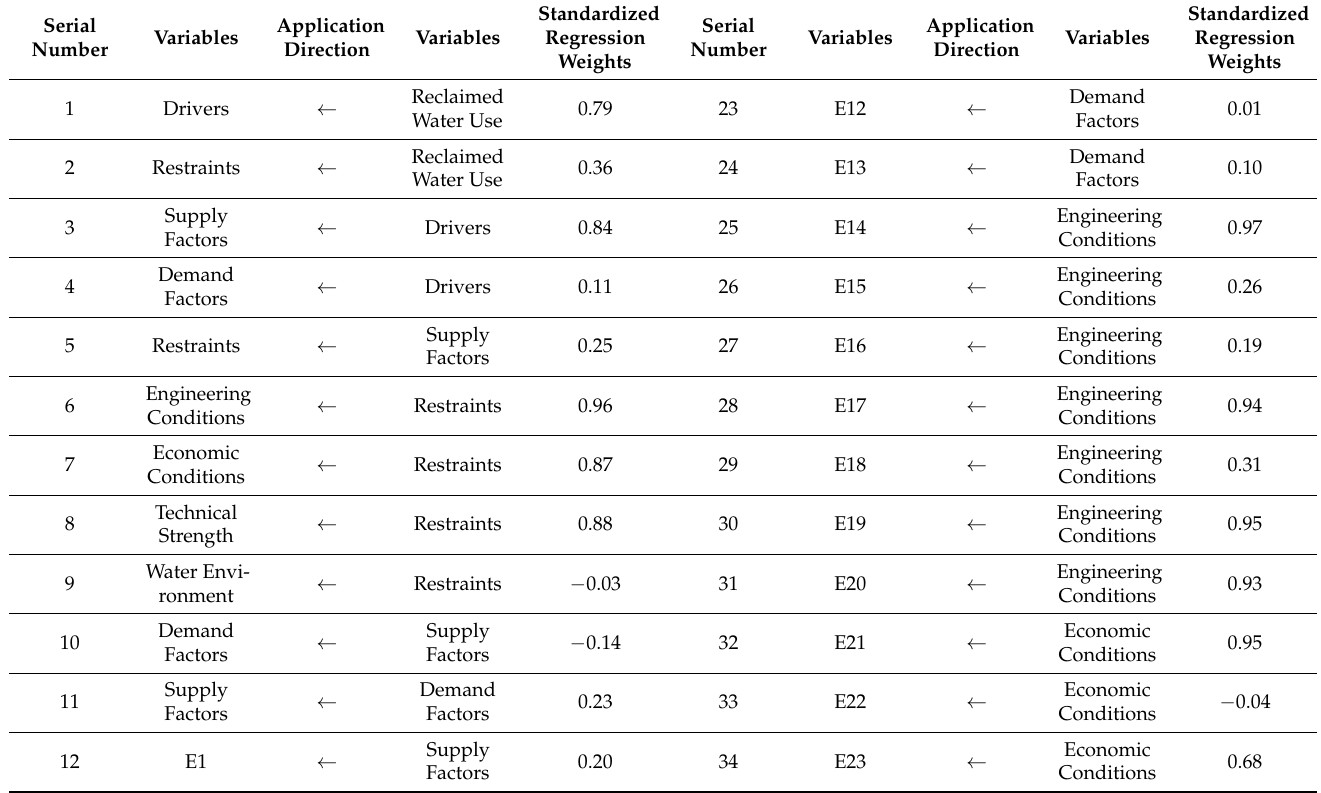
Table 3. Influencing paths of factors affecting reclaimed water use in the structural equation